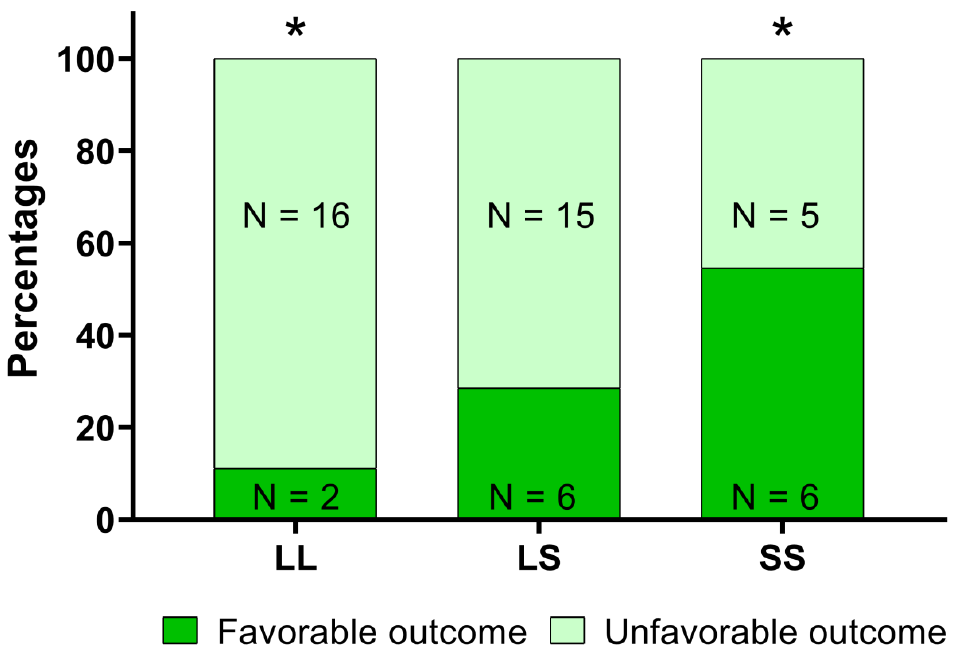
Figure 3. Analysis of 5-HTTLPR polymorphism and the rehabilitation outcome. In the figure, the percentages (together with the absolute numbers, N) of patients with or without a favorable outcome after a 6 week rehabilitation intervention, i.e., a score in the modified Barthel Index equal to or higher than 75, for patients with different 5-HTTLPR polymorphisms, are reported. According to the χ 2 test, there was a significant relationship between the polymorphisms and the rehabilitation outcome. The asterisks are related to the results of the post-hoc analysis and indicate a p value lower than 0.05. The post-hoc analysis, with Bonferroni’s correction, highlighted a statistically signifi- cant difference between patients with or without a favorable outcome in the LL (11.1% of